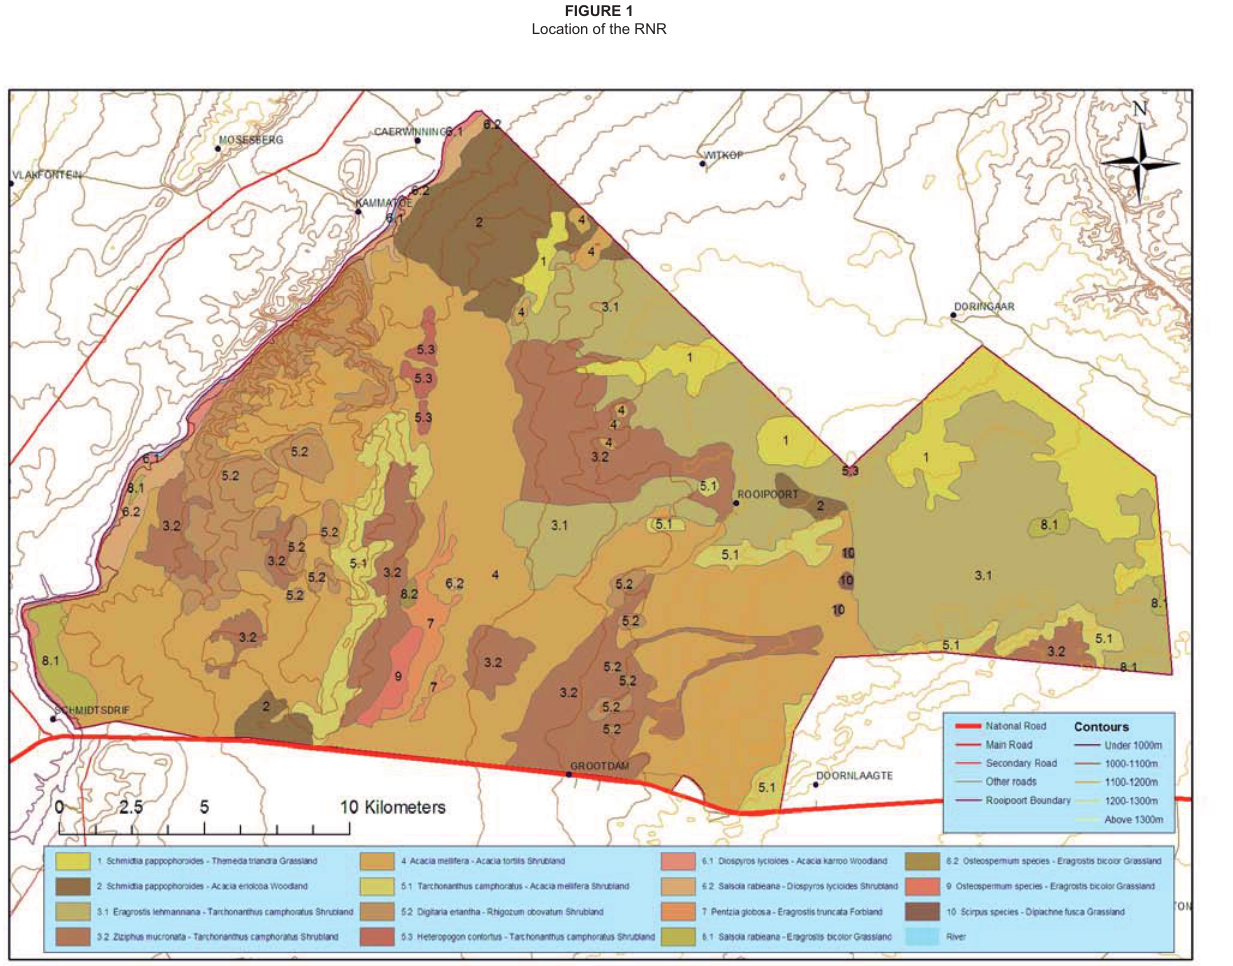
Figure 2 Vegetation map for the RNR